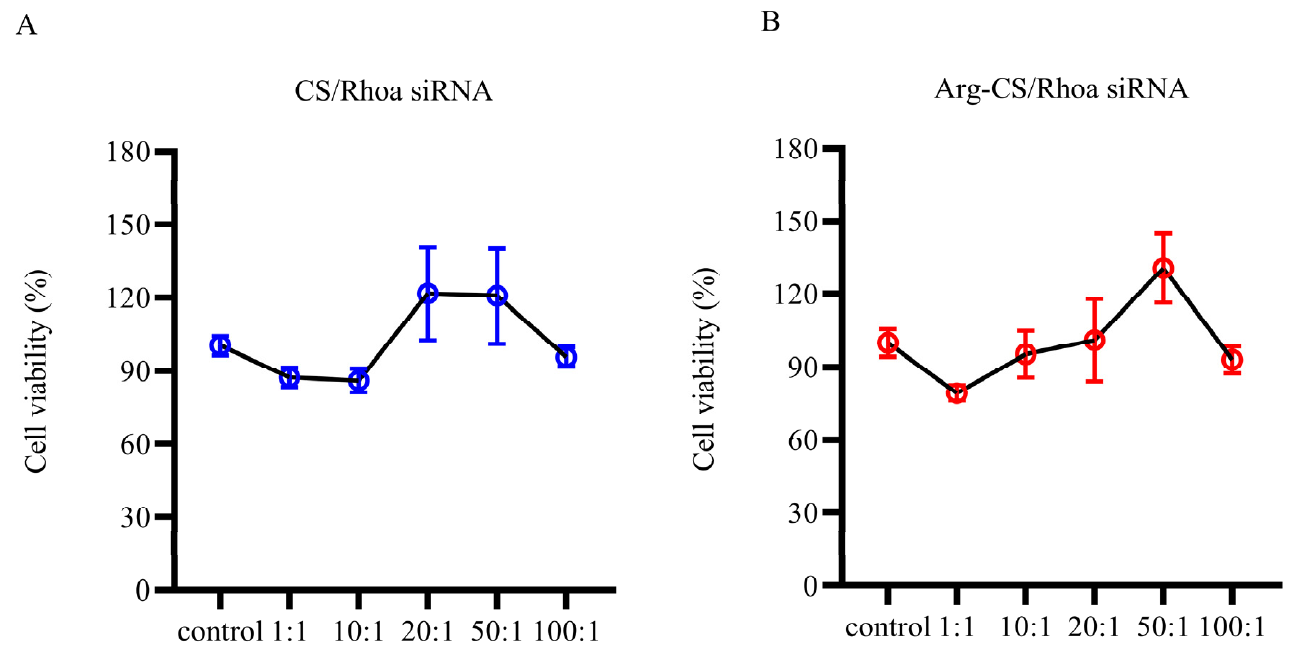
Figure 4. The cell viability of L1210 cells was not changed by Arg-CS/siRNA. ( A ) CS/siRNA and ( B ) Arg-CS/siRNA complexes were prepared as described in the Section 4, and cell viability was measured by the MTT assay ( n = 3).